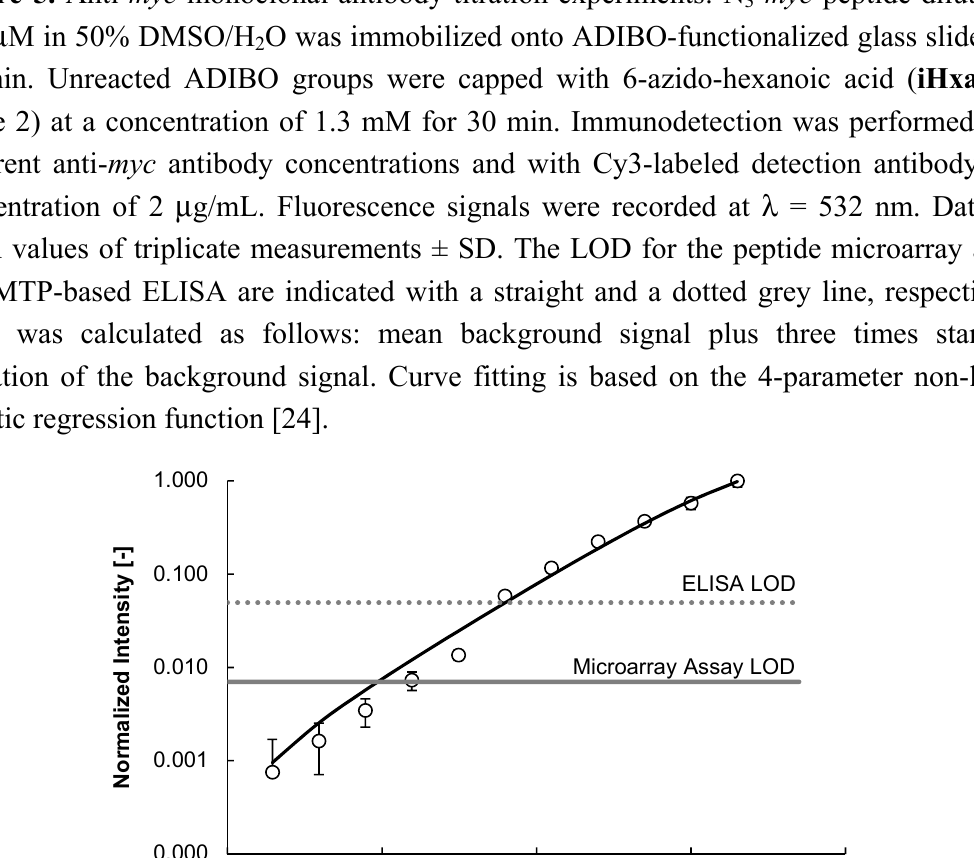
- myc peptide diluted to 3